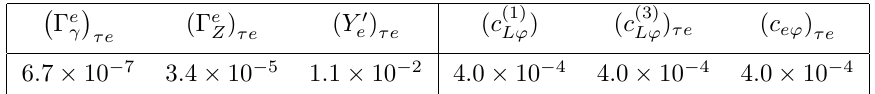
and c by τ → eπ + π − eϕ Lϕ